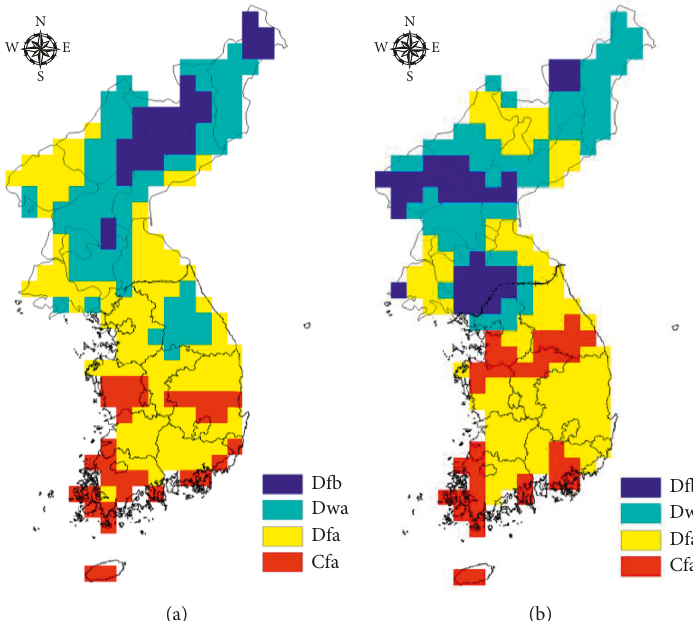
Figure 10: Spatial distribution of climatic zones for observation and simulated climates. (a) Historical. (b)